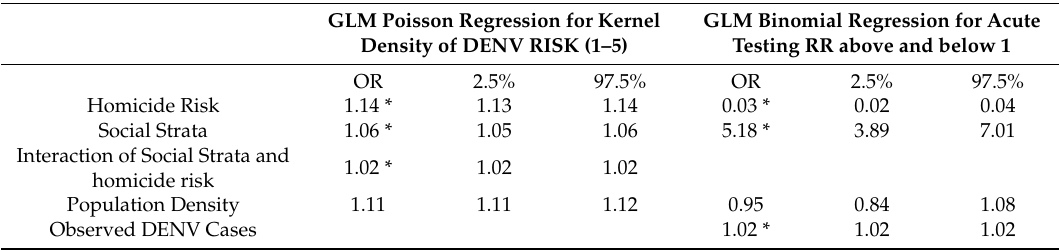
Table 3. DENV cases reported by region by social strata and homicide risk (GLM, Poisson) and GLM binomial regression for acute testing Relative Risk above and below 1. GLM Poisson Regression for Kernel GLM Binomial Regression for Acute Density of DENV RISK (1–5) Testing RR above and below